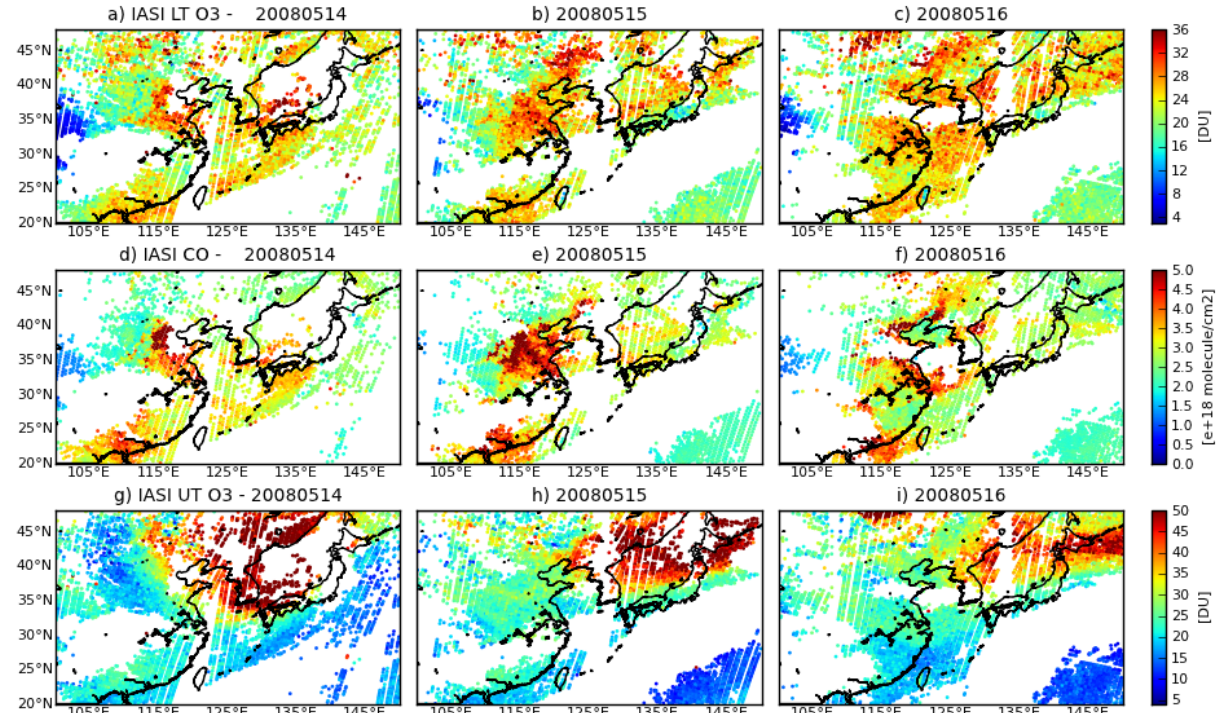
Figure 6. Same as Fig. 5 but for 14 to 16 May